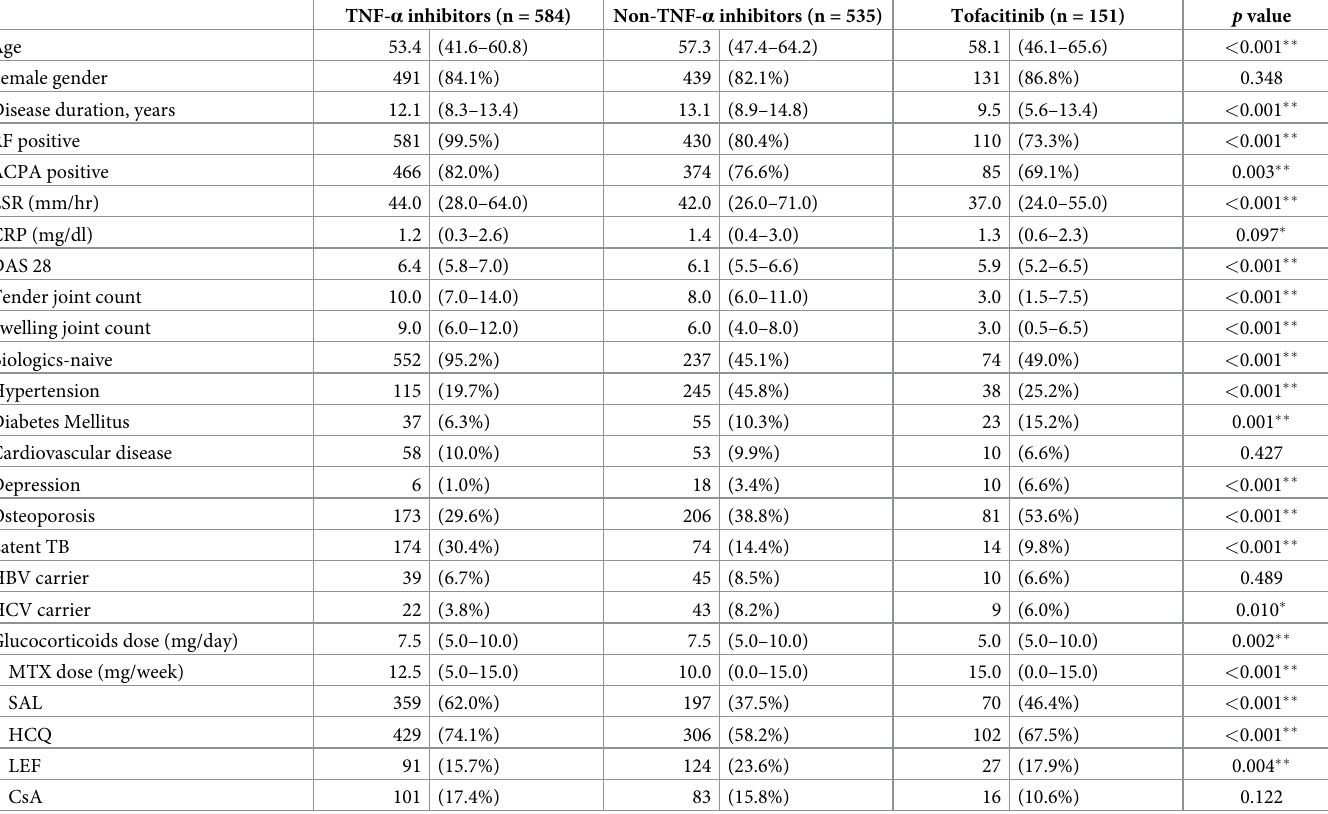
Table 1. Demographic data of RA patients receiving bDMARDs and